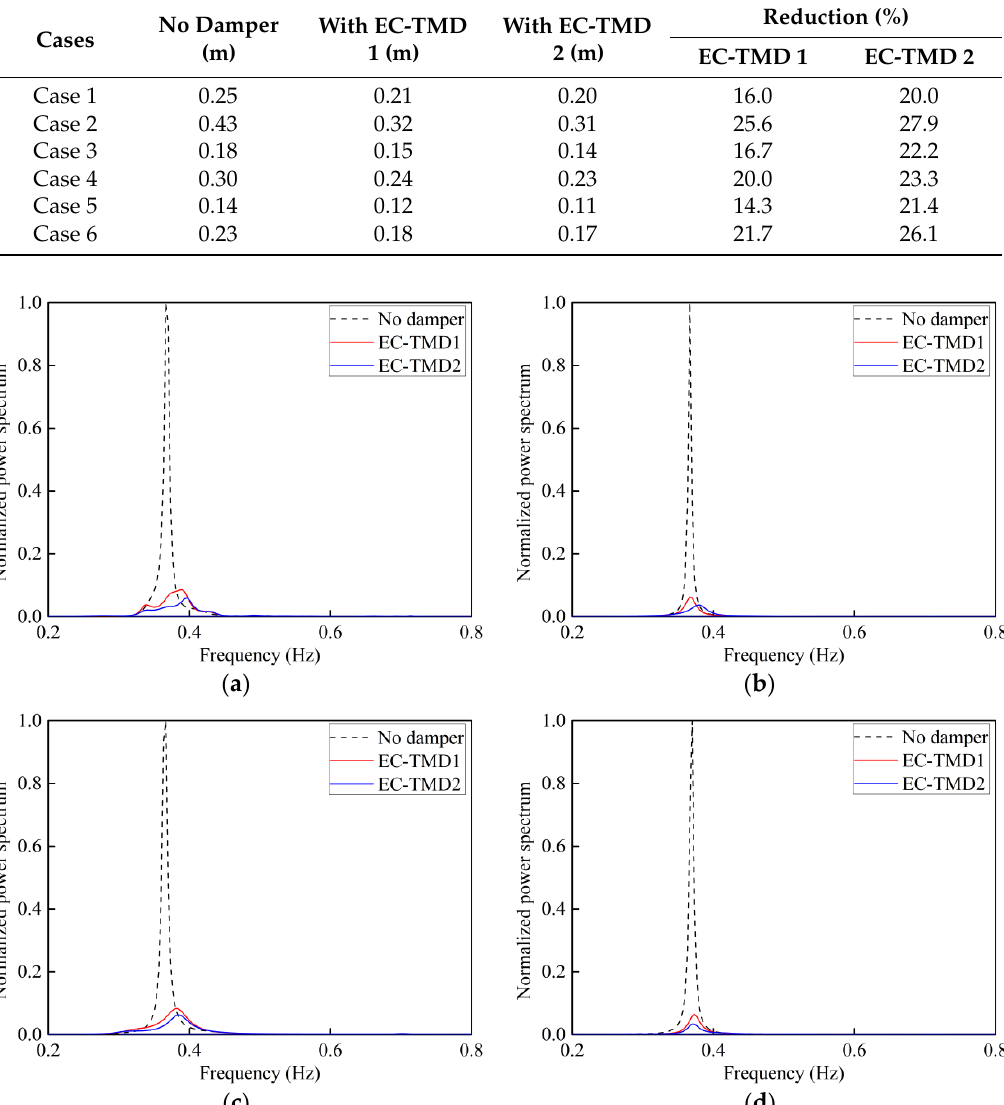
Figure 17. Acceleration power spectral density at the top of the tower with Class I and Class III: ( a ) Class I with 1 year’s recurrence period; ( b ) Class I with 50 years’ recurrence period; ( c ) Class III with 1 year’s recurrence period; ( d ) Class III with 50 years’ recurrence period .